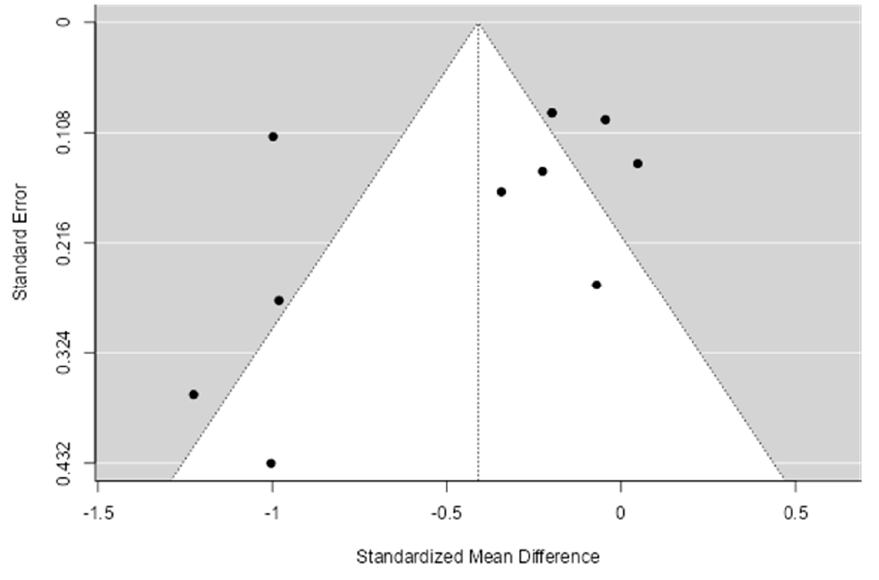
Figure 5. Funnel plot intervention vs. control of telecoaching in achieving a HbA1C